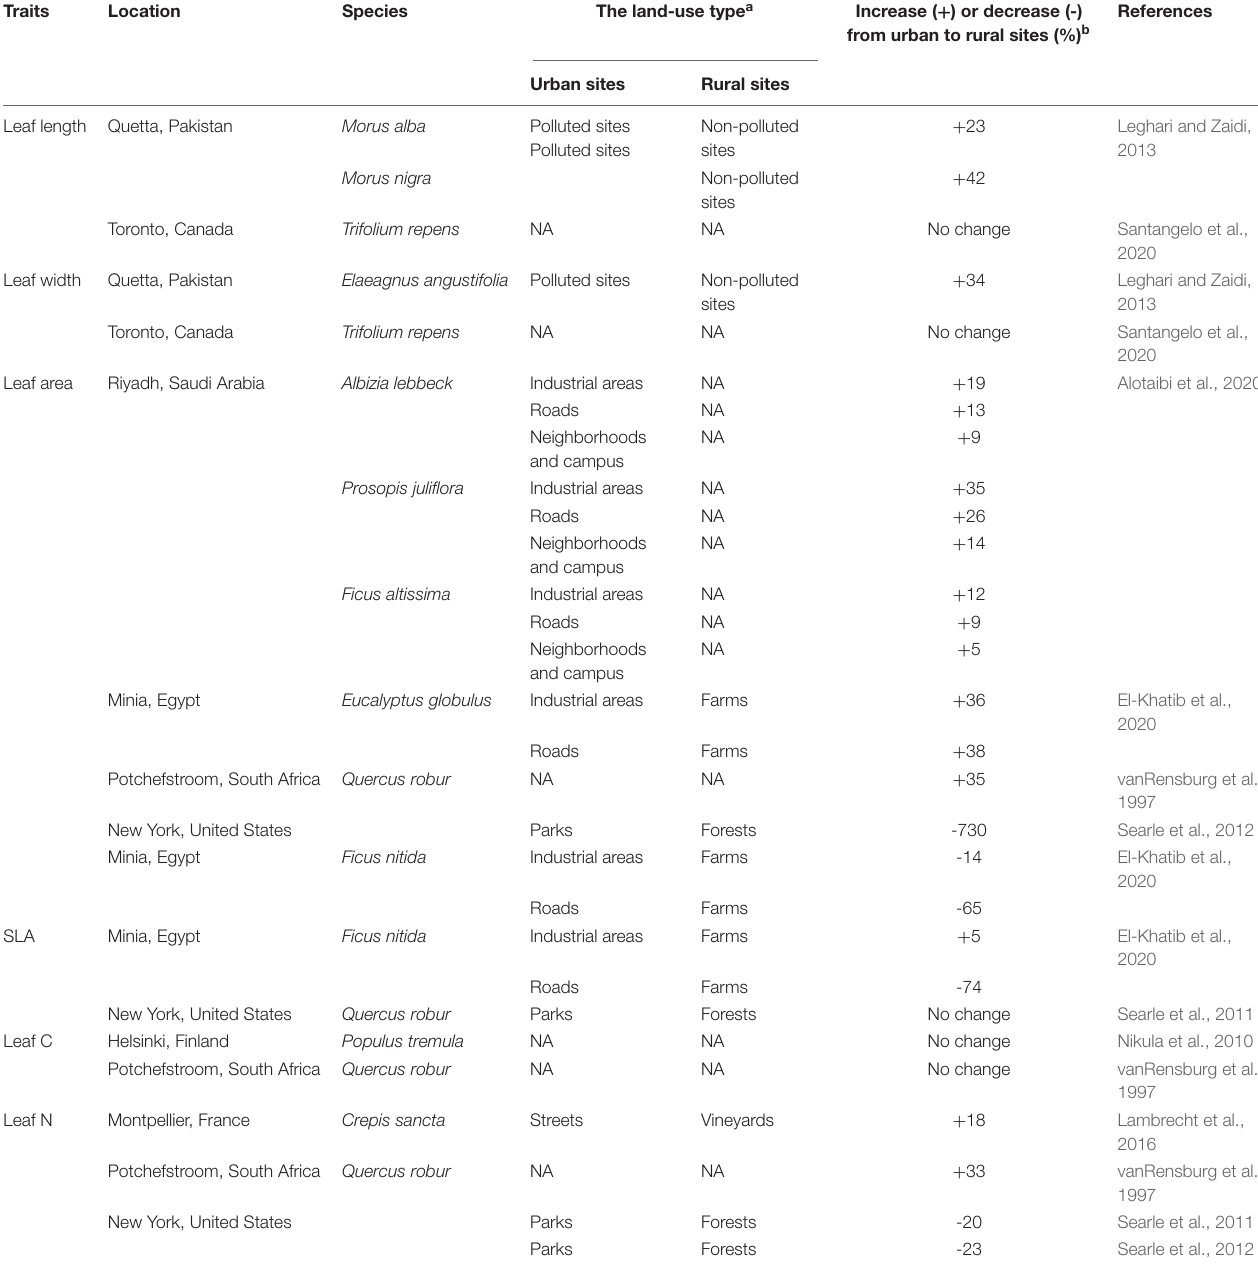
TABLE 1 | Differences in leaf functional traits of plants between urban and rural sites. Traits Location